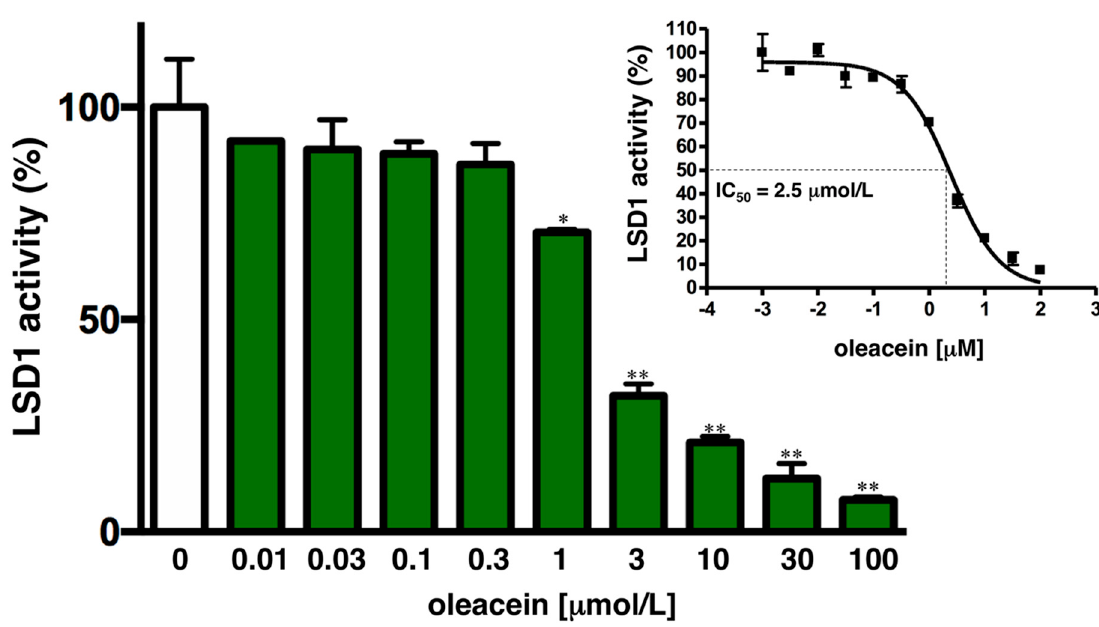
Figure 3. Oleacein inhibits LSD1 activity. Dose–response curves of LSD1 demethylation activity were created by plotting AlphaScreen signals as the function of oleacein concentration. Data (mean values and S.D. bars) are representative of two independent experiments (* p < 0.05, ** p < 0.005).